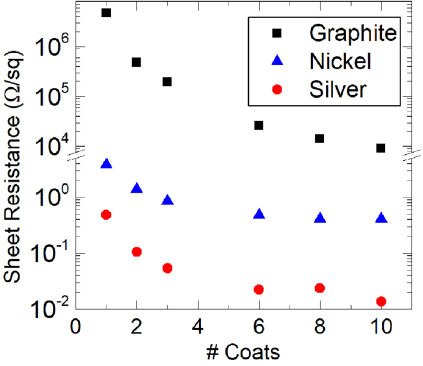
Fig. 3 Sheet resistance of graphite, nickel, and silver spray conductors as a function of the number of coats applied